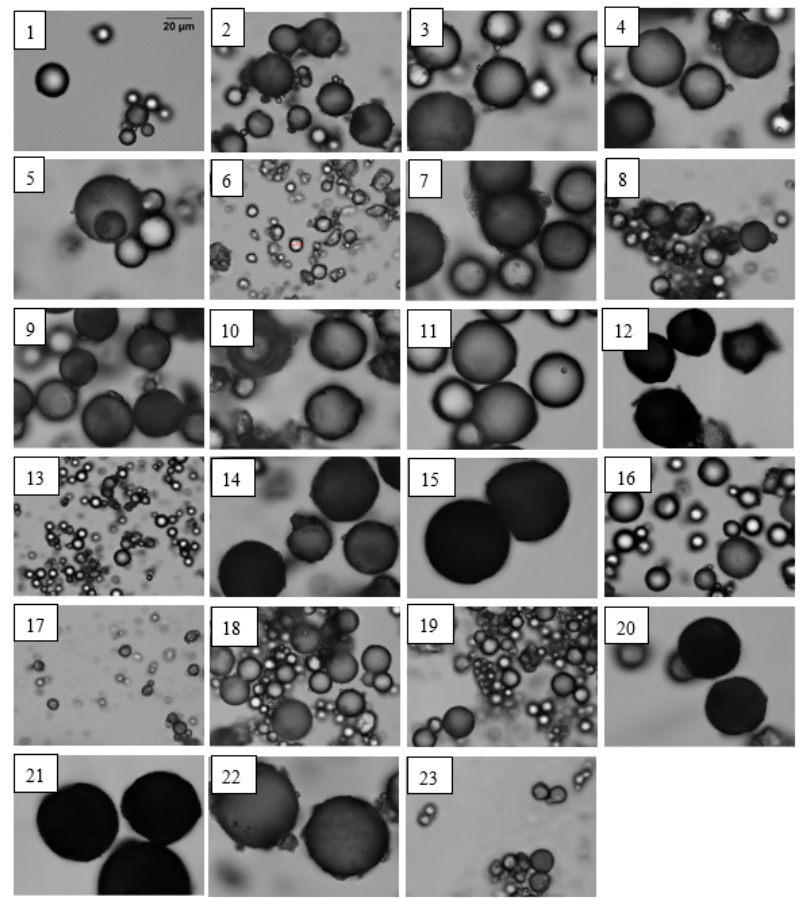
+ St + DVB, 2-SL-ea + St +